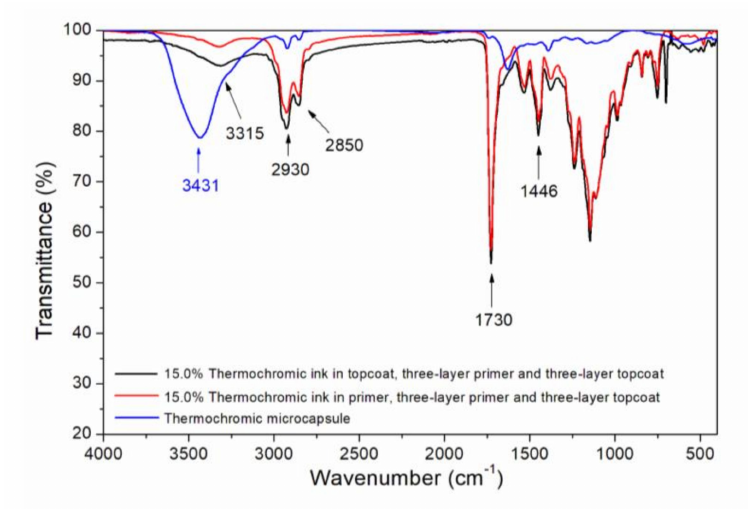
Figure 12. Infrared spectra of the waterborne coating with di ff erent coating process and thermochromic microcapsules.